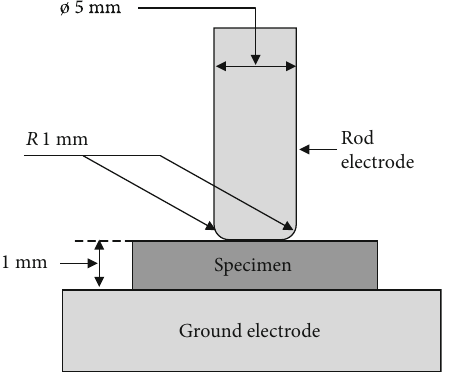
Figure 3: Arrangement of rod-ground electrodes for PD test.